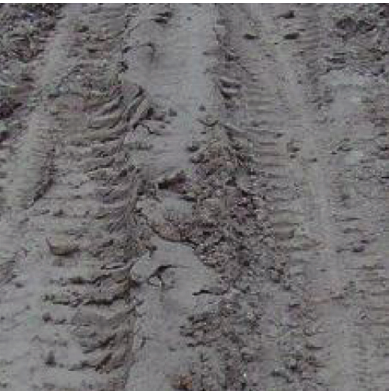
Figure 7: Image of mud pavement after